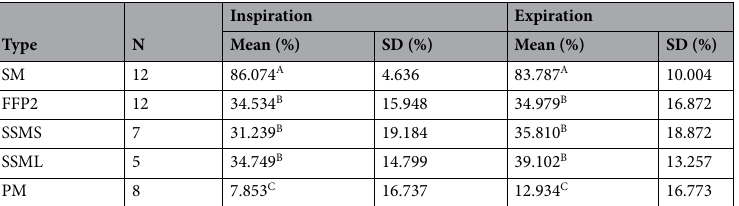
Table 1. Leakage during inspiration and expiration given for each mask. Groups with the same superscript letters (A, B, C) did not differ significantly. SD standard deviation, SM surgical mask, SSMS statistically shaped mask S, SSML statistically shaped mask L, PM personalized mask.